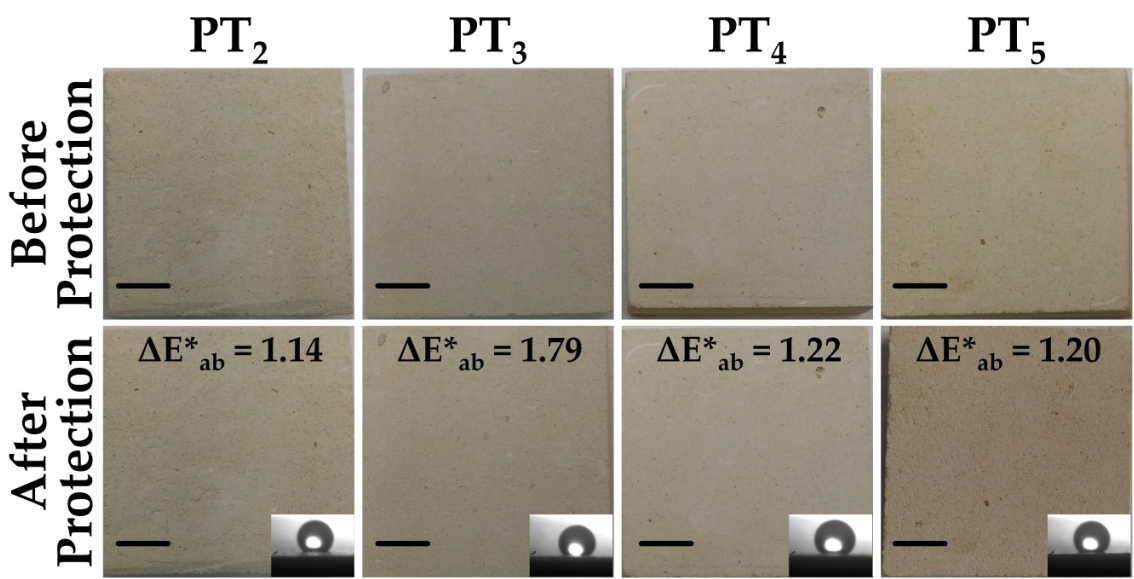
Figure 2. Stone specimens before and after the application of the protective treatments; the color changes (as ∆ E* ab ) and water droplets on the protected stone surfaces are shown. Each scale bar indicates 1 cm.